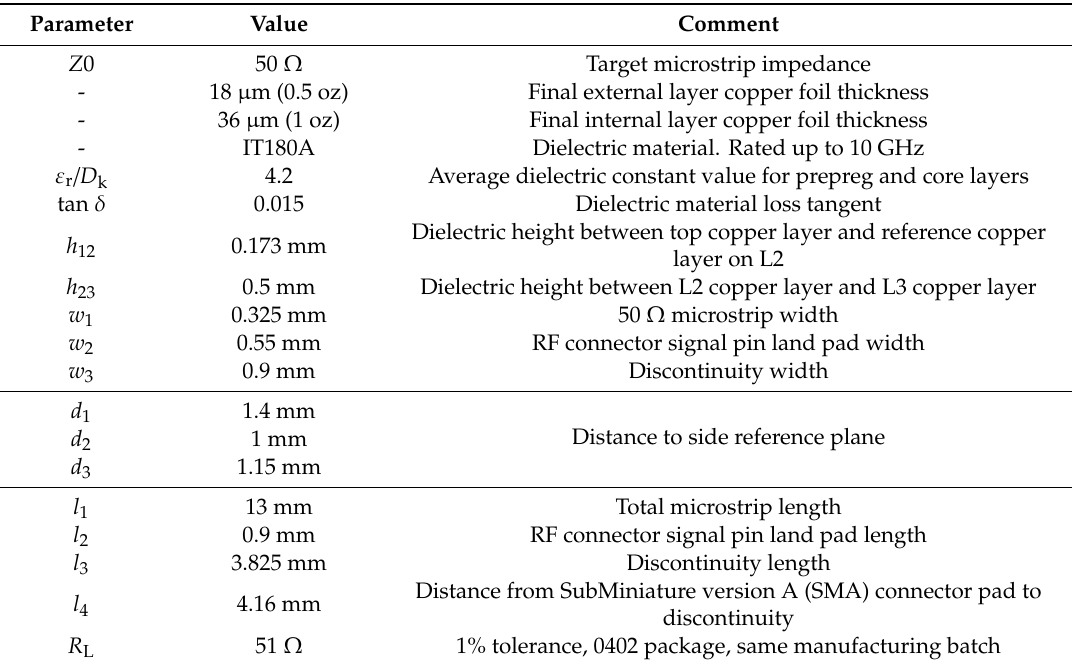
Table 1. Detailed device under test (DUT) structure